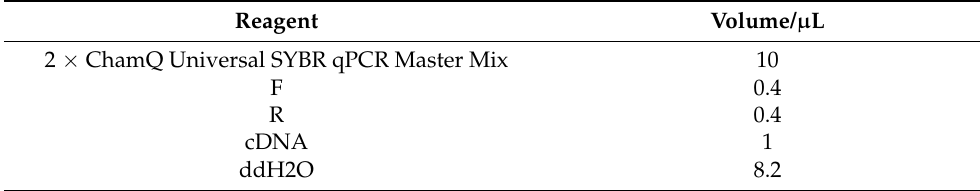
Table A2. Reaction system of qPCR.